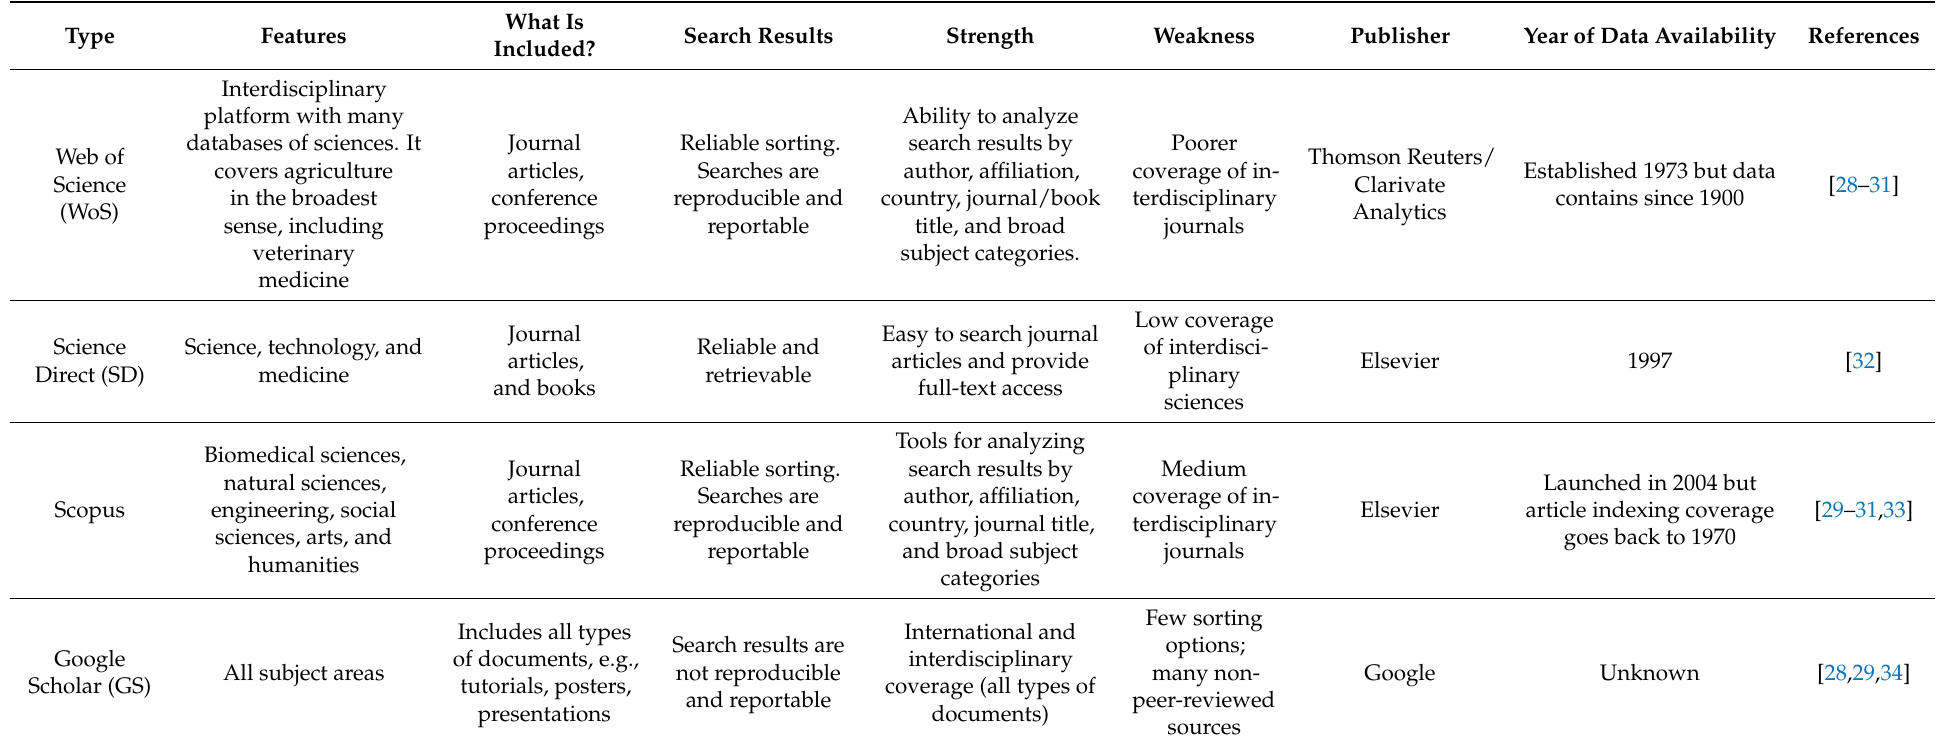
Table 1. Bibliographic database source